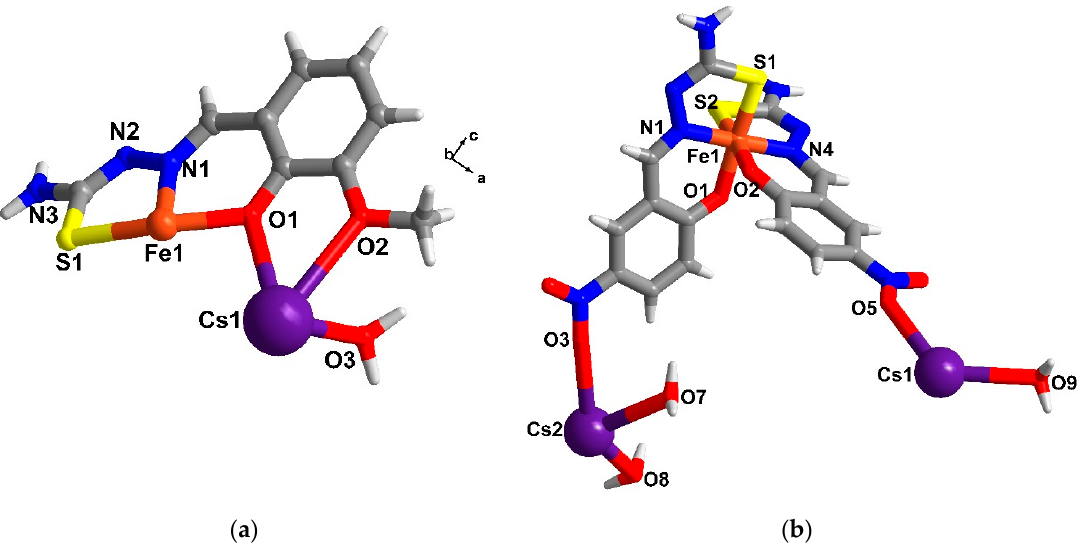
Figure 6. Representation of the asymmetric unit of ( a ) 5 and ( b ) 6 . Notably, some atoms contain 0.5 occupancy in the asymmetric unit i.e., Fe1, Cs1 and O3 in 5 , and Cs1, Cs2, O8 and O9 in 6 .